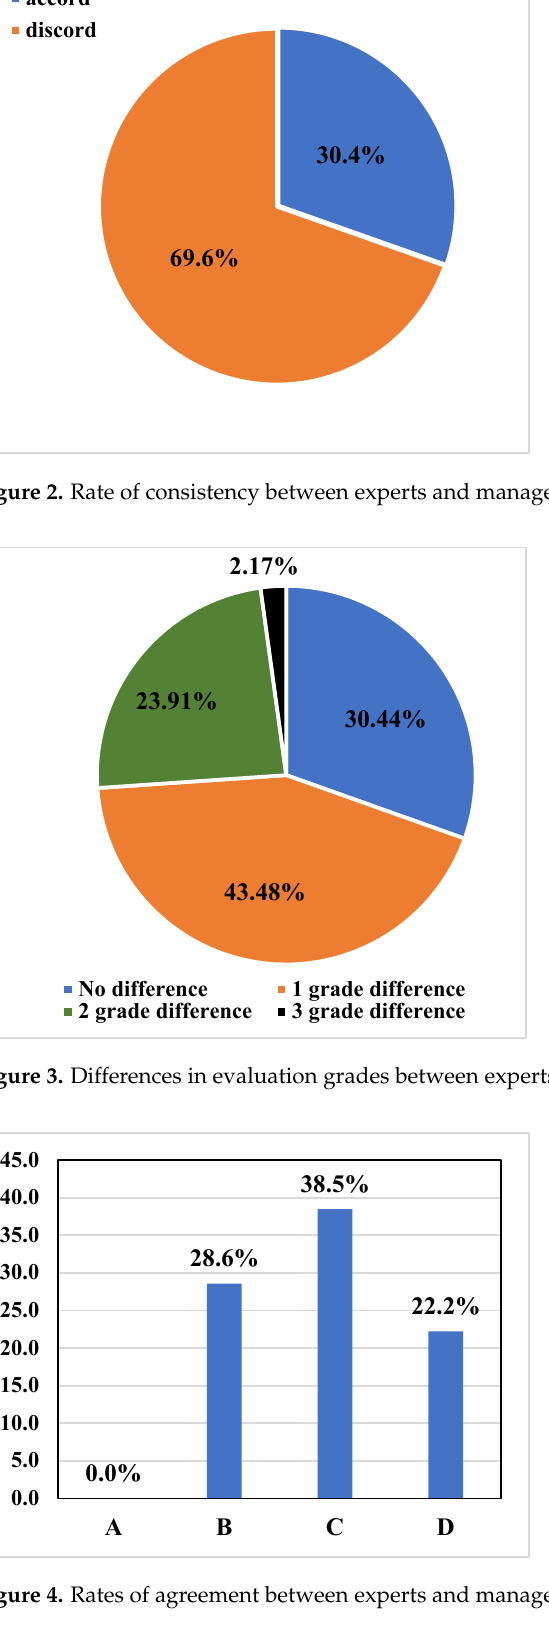
Figure 4. Rates of agreement between experts and management staff by ratings .